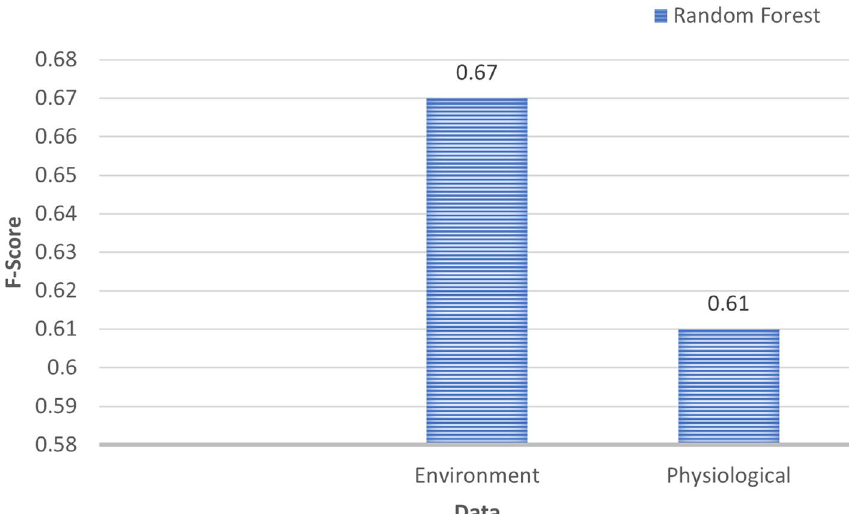
Fig. 14 Comparison of Random Forest combined with CNN when trained using only the environmental or physiological